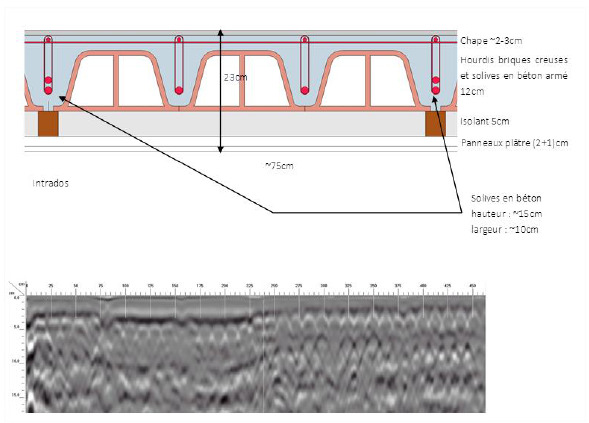
Figure 6. © A-BIME: Radargramme: structure of the vault